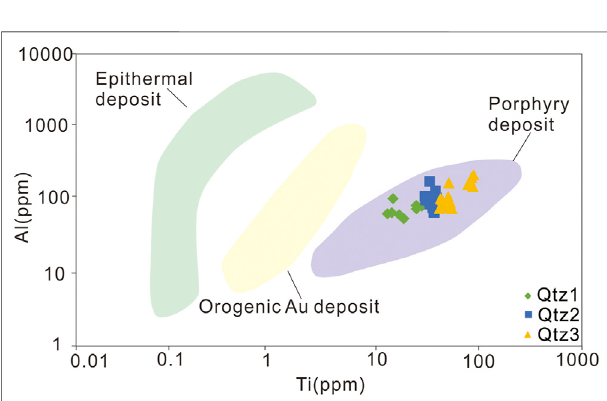
FIGURE 11 | Diagram of Ti vs Al contents of quartz in the Hongniu- Hongshan deposit compared with data from Rusk (2012) including porphyry- type deposits, orogenic Au deposits, and epithermal